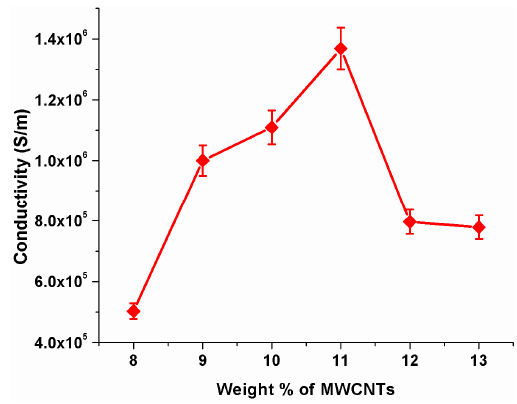
Figure 6. Variation of Electrical Conductivity as a function of MWCNTs weight.